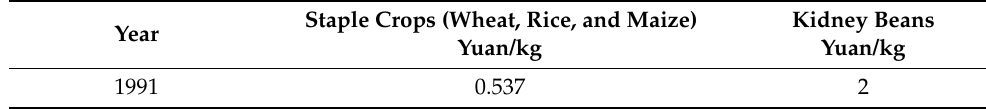
Kidney Beans Yuan/kg